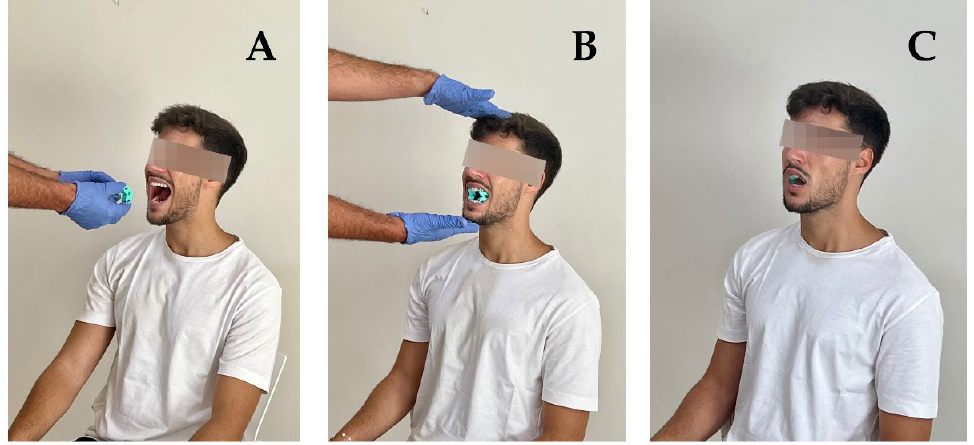
Figure 1. Isometric contraction test of the occlusive masticatory muscles. ( A ) First, the subject opens the mouth; ( B ) second, the assessor inserts the teethers in the subject’s mouth; ( C ) third, the subject clenches the teeth during 40 s.